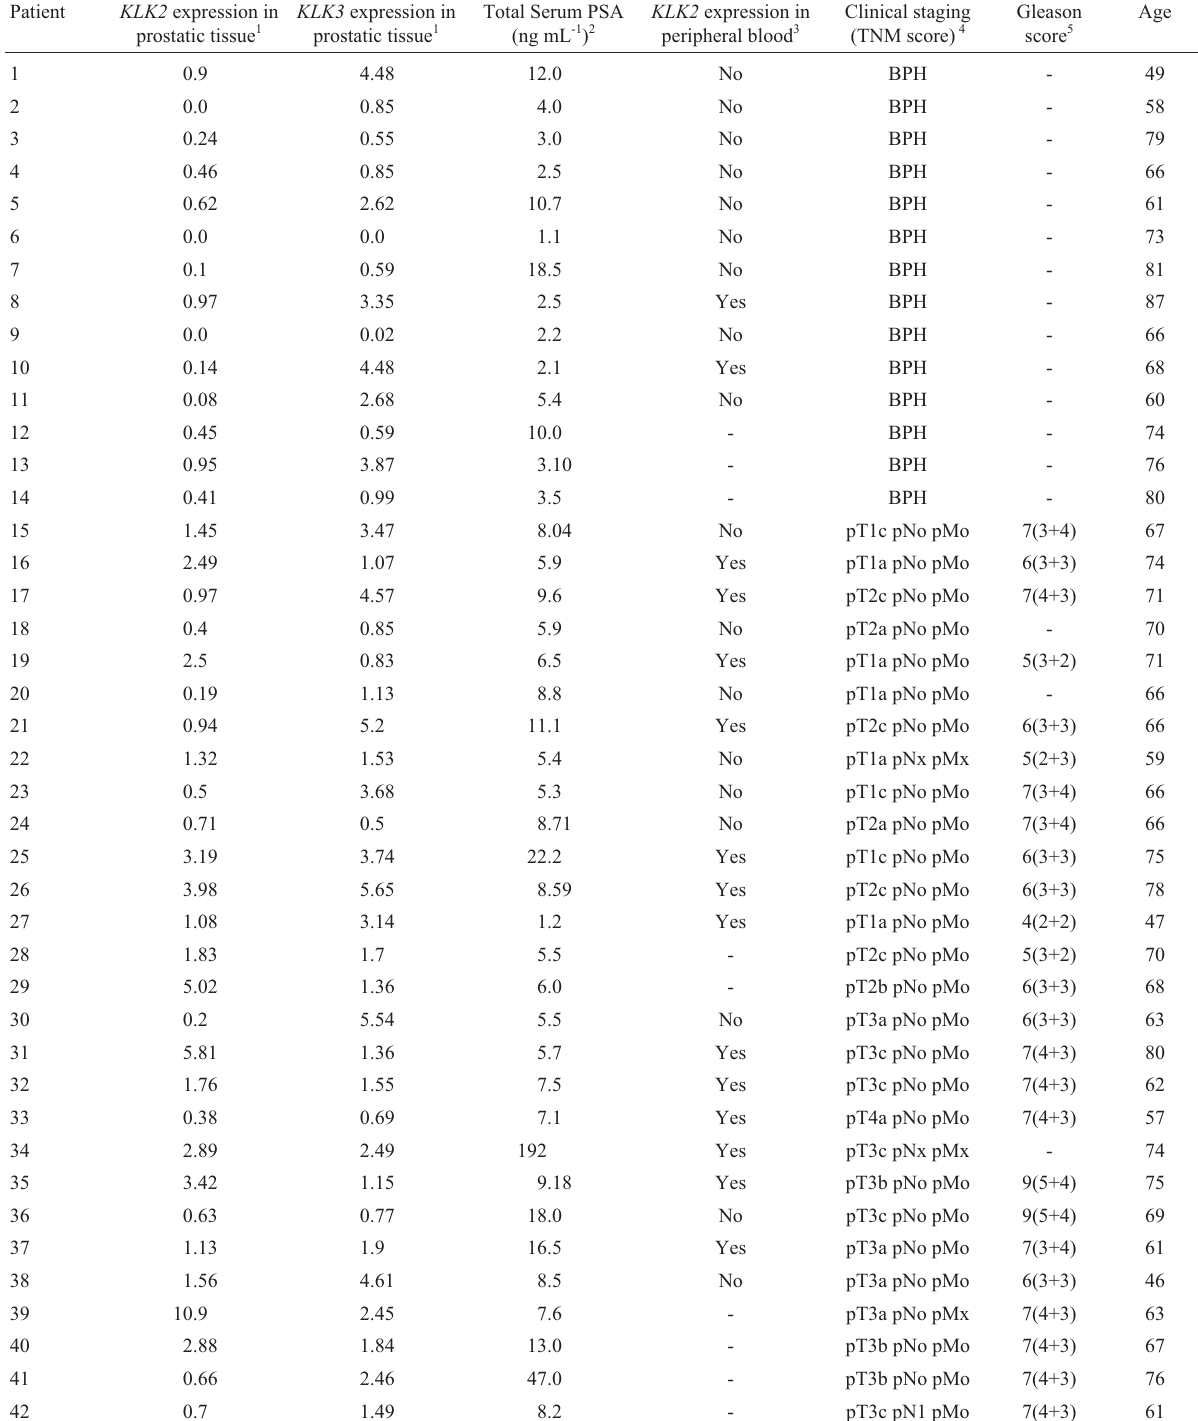
Table 1 - Clinical parameters and laboratory data for expression analyses of the KLK2 and KLK3 genes in prostatic tissues and peripheral blood.